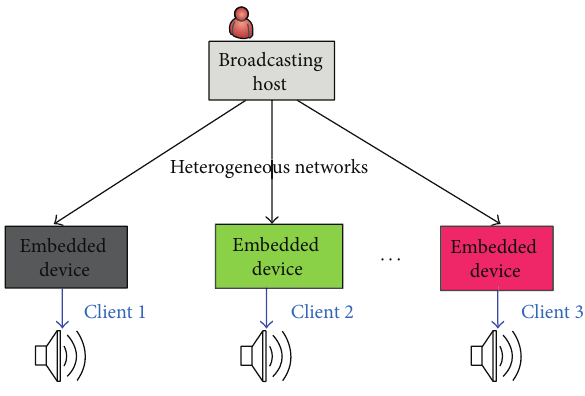
Figure 2: Conceptual